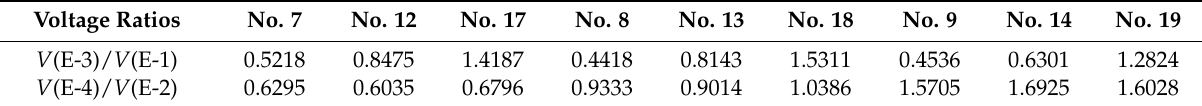
Table 4. Voltage ratios of No. 7 to No.19 from E-1 to E-3 calculated using MATLAB.